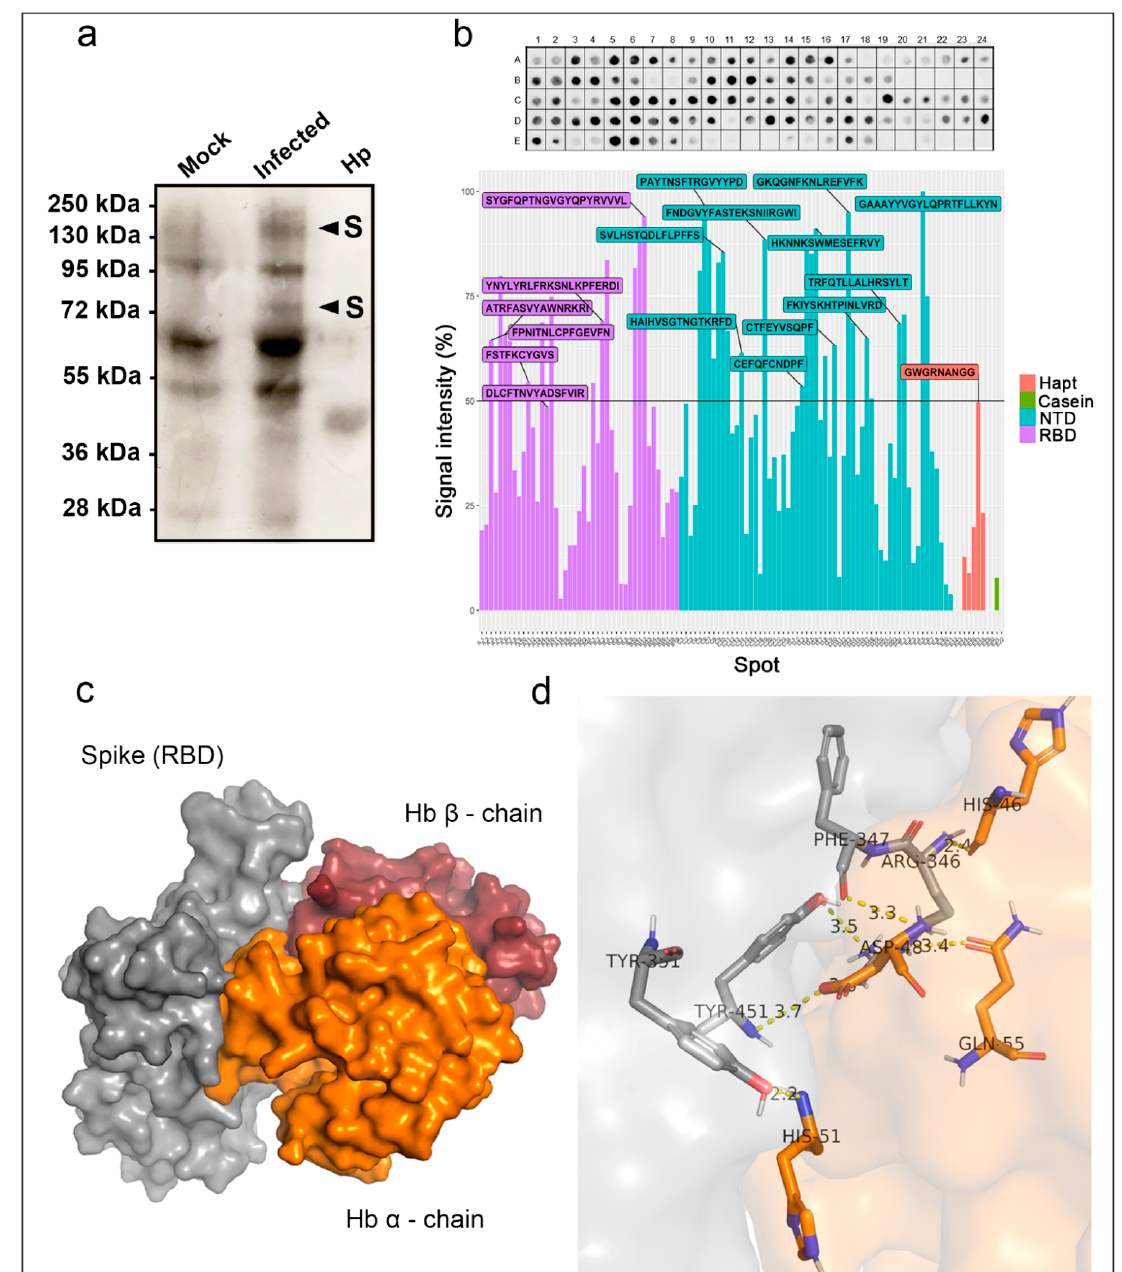
Figure 3. Hemoglobin (Hb) binding to spike protein and RBD enhancement. ( a ) Total protein extracts (20 µg) of SARS-CoV-2-infected Vero E6 cells (Infected) or mock-infected cells (Mock; 20 µg) were separated by SDS-PAGE (10%) along with haptoglobin (Hp; 2 µg), transferred to a nitrocellulose membrane, and serially incubated with Hb (10 µg/mL), anti-Hb antibody, and peroxidase-conjugated secondary antibodies. Two bands at 72 and 150 kDa were exclusively found in SARS-CoV-2 infected extract (arrowhead). ( b ) Spot synthesis analysis with a library of 15-mer peptides offset by five amino acids to represent the RBD region (purple) and NTD (blue) of the spike protein, haptoglobin (Hapt; red), and casein (green) as a positive and negative control, respectively. Sequences were synthesized directly onto a cellulose membrane followed by probing with Hb (5 µg/mL) and revealed by anti-human Hb antibodies. The top panel shows the chemiluminescent image of signals from peptides bound to Hb. The bottom panel shows a graph of the signal intensities normalized to the maximum signal. An intensity level above 50% defined Hb-reactive peptides. Molecular docking of SARS-CoV-2 spike protein with human hemoglobin. ( c ) Interaction of spike protein (gray) with α -chain Hb (orange) and β -chain (red). ( d ) Representation of amino acid residues binding to spike protein (sticks and gray) with α -chain of hemoglobin